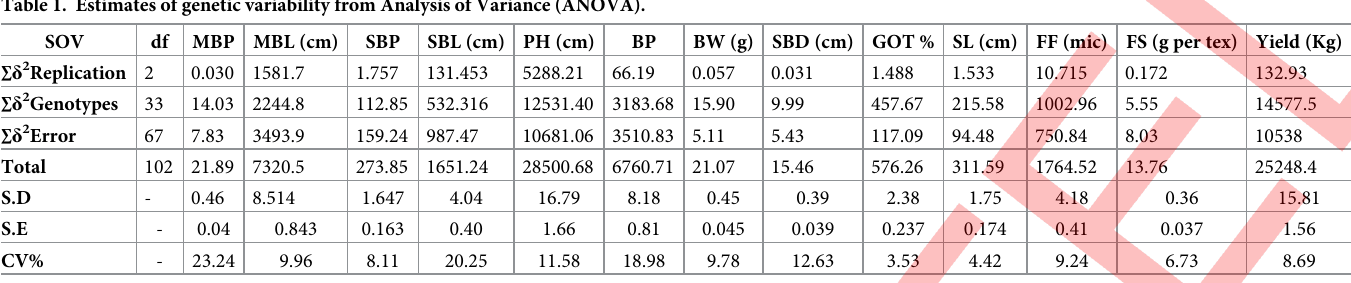
Table 1. Estimates of genetic variability from Analysis of Variance (ANOVA).